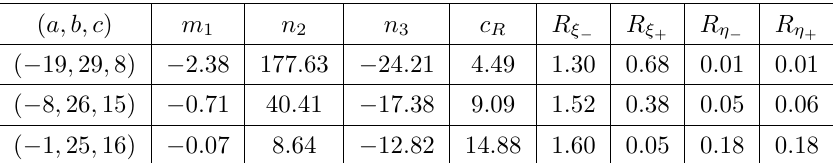
= c sugra (divided by N 2 ), and the R-charges (divided by N R